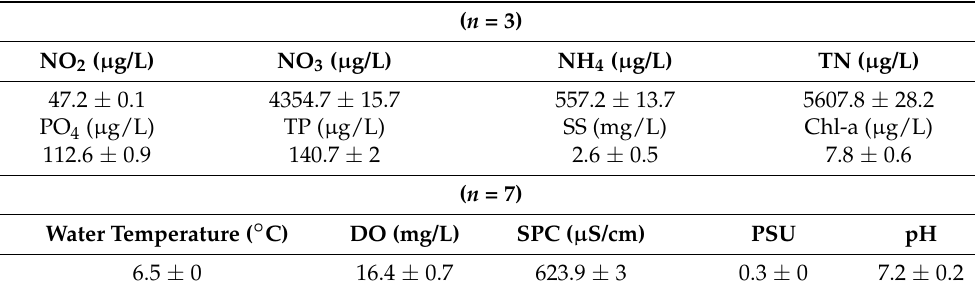
Table 1. Environmental conditions of the studied